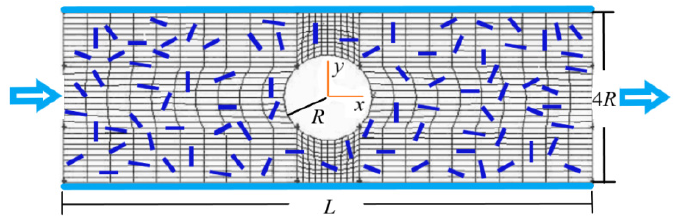
Figure 2. Schematic of a flow and grid division.